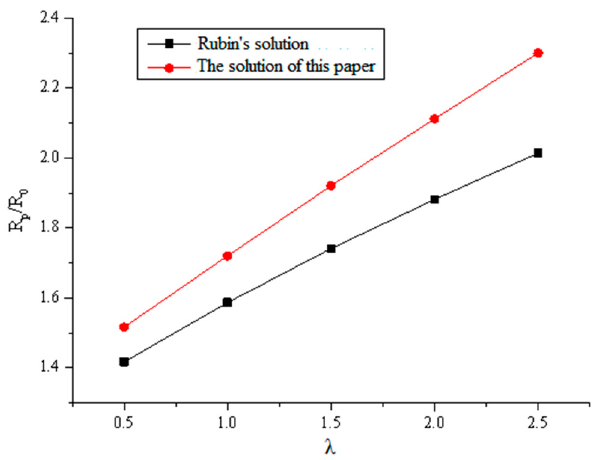
Figure 5. Plastic range under different lateral pressure coefficient.